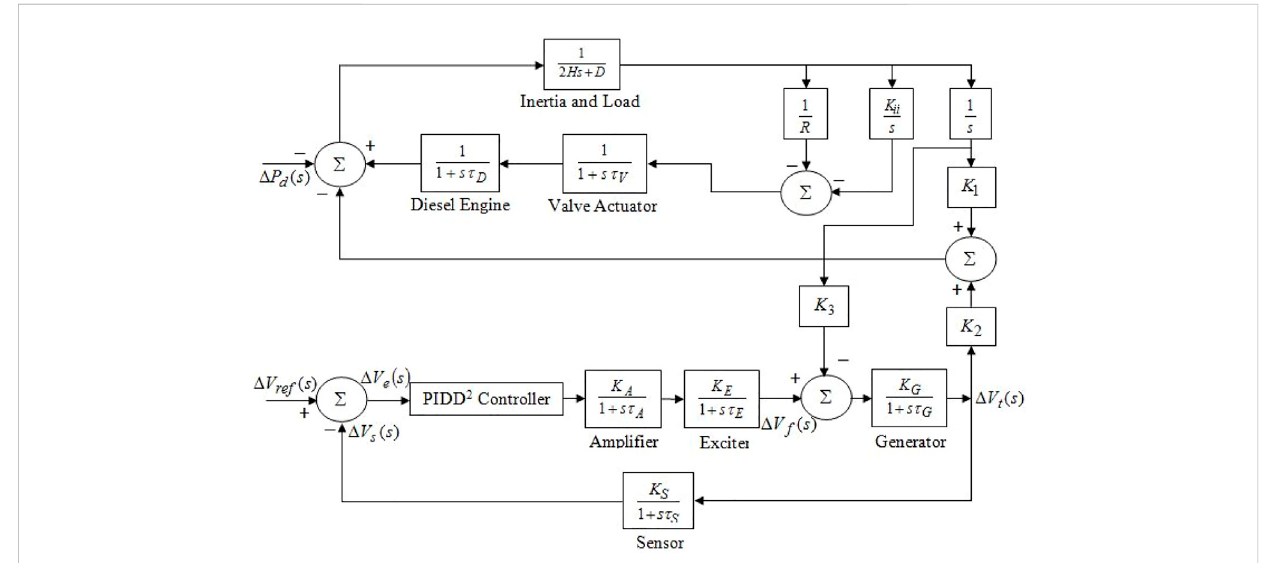
FIGURE 1 Block diagram of the investigated APS ’ s transfer